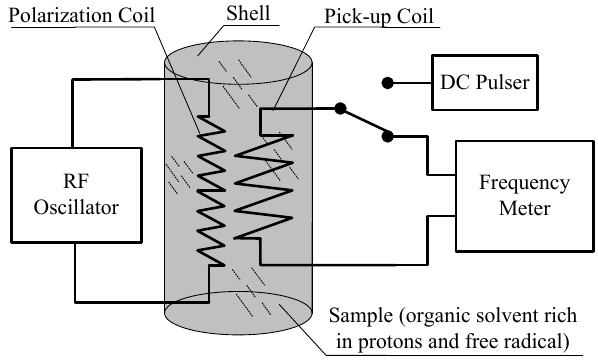
Figure 2. Scheme of the Overhauser geomagnetic